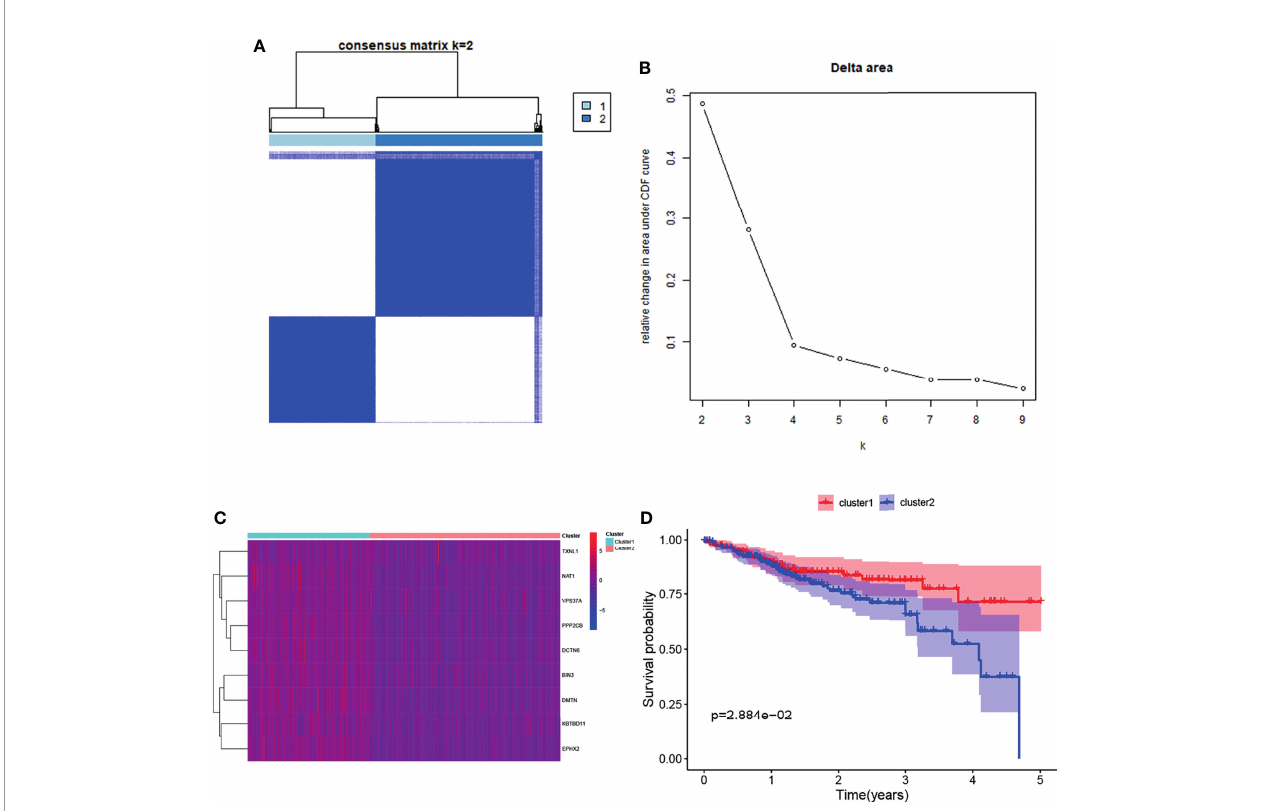
FIGURE 3 | Clustering and survival analysis based on mRNA expression levels of target genes in the TCGA database. (A, B) Results of consistent cluster matrix, cumulative distribution function curve, and relative change in area under the curve showed that the expression of target genes could be divided into two types of CRC samples. (C) Heatmaps of gene expression in the cluster1 and cluster2 groups. (D) K – M survival curve showed that patients with cluster1 showed higher survival ability than those with cluster2 ( p <